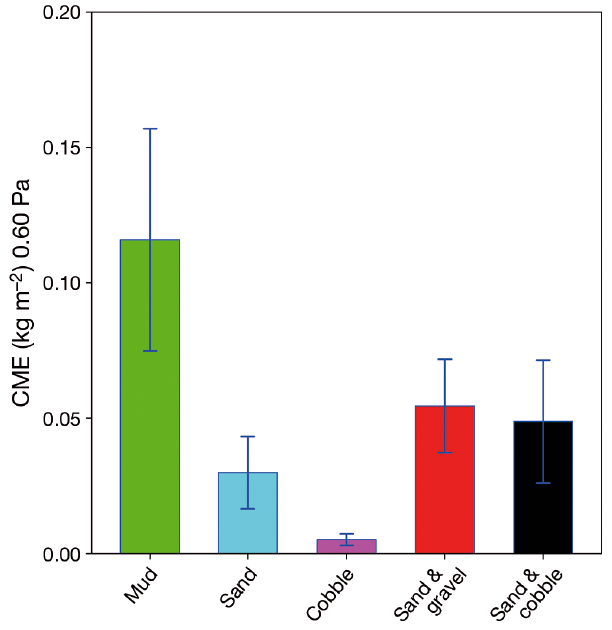
Fig. 3. Cumulative mass eroded (CME; mean ± SD; kg m −2 ) up to and including the 0.60 Pa shear stress step for the erosion experiments (n = 6 per substrate type) using salmon fecal waste material. Results are normalized to % recovery of waste material from the 5 different bottom substrates (mud, sand, cobble, sand and gravel, sand and cobble)